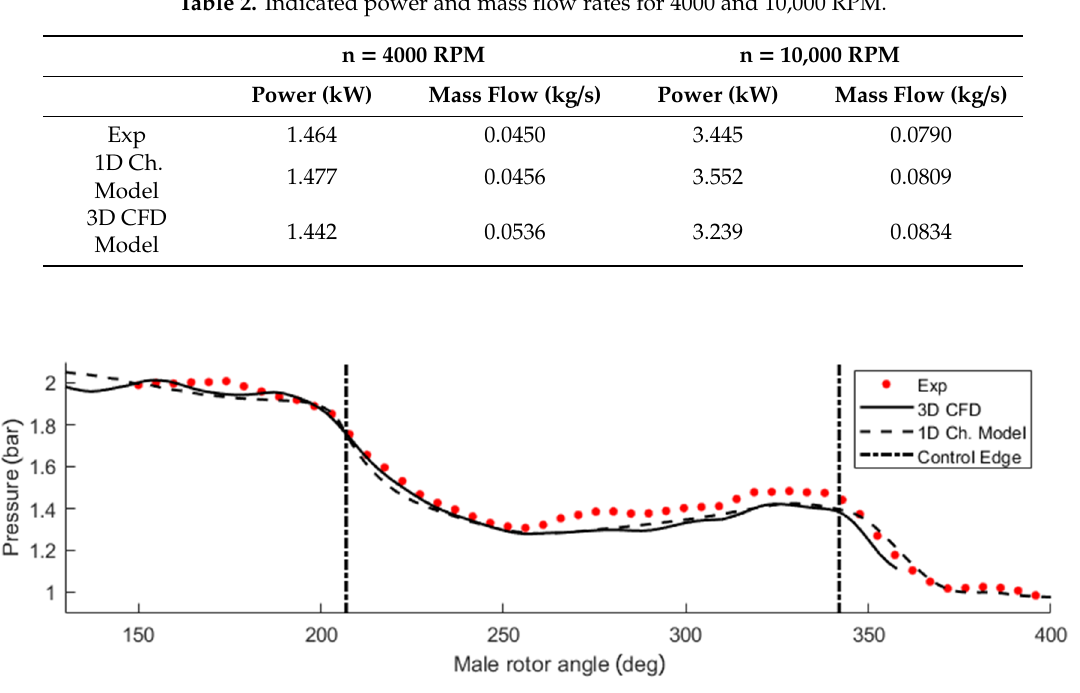
Figure 7. Validation of simulated pressure curves against male rotor’s rotational angle (n = 4000 RPM, Pi = 2 bar and Ti = 75 °C).